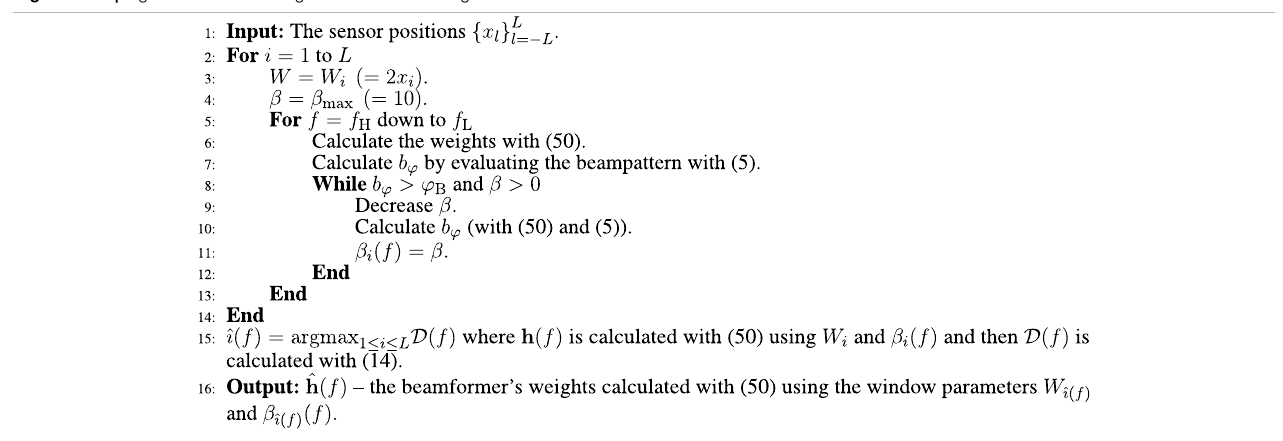
Algorithm 1 | Algorithm for calculating the beamformer weights.